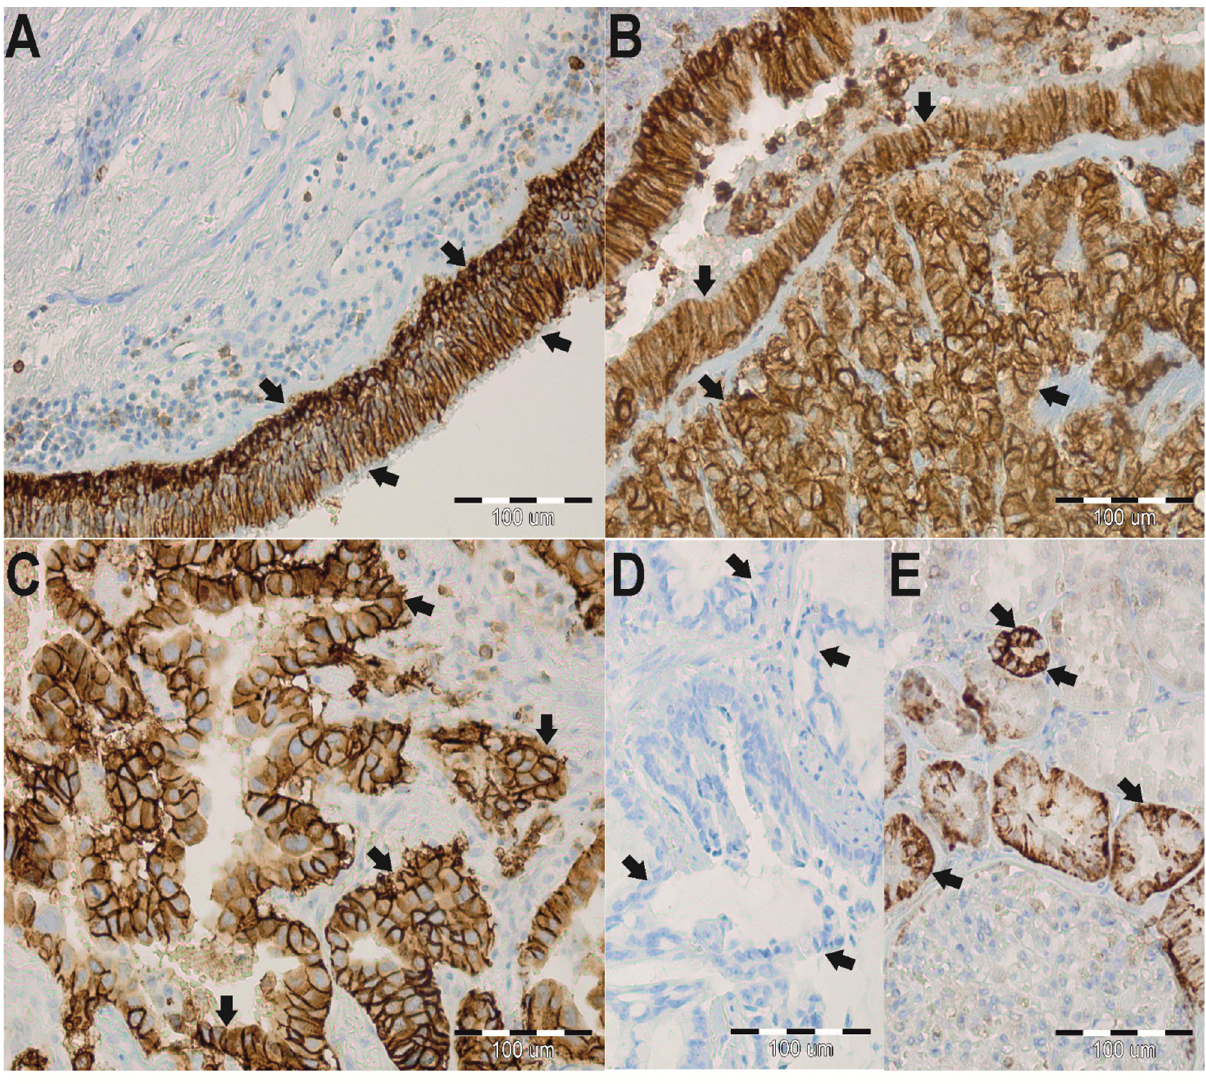
Figure 1. Immunohistochemistry (IHC) staining of aquaporin 3 (AQP3) in paraffin-embedded sec- tions of the lung adenocarcinoma (ADC) from humans. Anti-AQP3 antibody labels in non-neoplastic lung tissues. Arrows indicate the localization of the basolateral plasma membranes of surface epithelium in whole plasma membranes of basal cells of the bronchus ( A ). Anti-AQP3 antibody labels in the cancer lung tissues. Arrows indicate the localization of AQP3 in the cytoplasmic mem- brane in the cancer cells ( B , C ). No staining was observed when isotype-specific immunoglobulins from non-immunized rabbits were used instead of the primary antibody (negative control) ( D ). Immunoperoxidase labeling of AQP3 from the human kidney (positive control) ( E ). The labeling is seen in the basolateral plasma membrane of the renal collecting ducts. The blue color repre- sents a positive staining for the hematoxylin counterstain, and the brown color represents positive AQP3